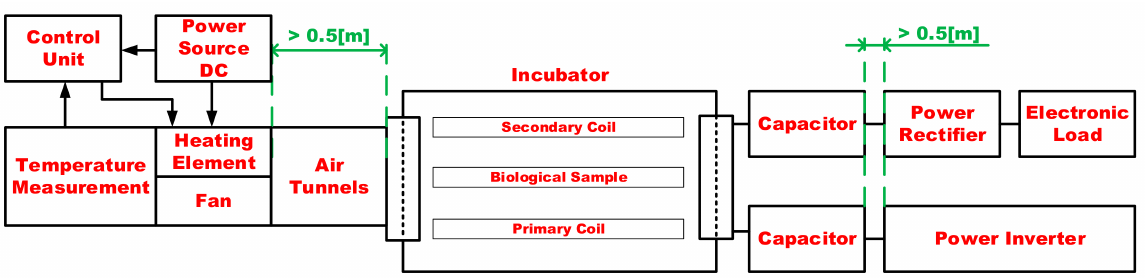
Figure 2. Block diagram of WPT measurement within the incubator with the air-conditioning system.